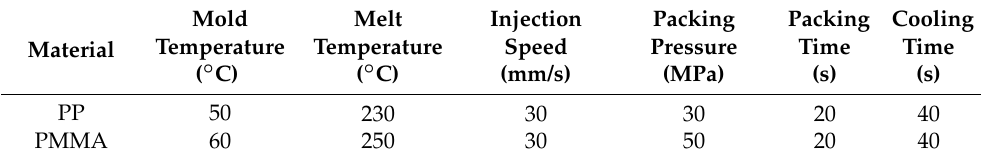
Figure 6. The diagram of the shape, dimensions, and the measured region of the base portion part. Table 2. Processing parameters in LU µ IM of PP and PMMA base portion Table 2. Processing parameters in LUμIM of PP and PMMA base portion parts.